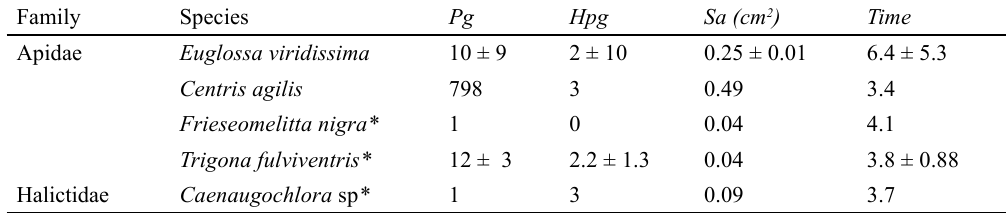
Table 2. Pollen loads on floral visitors and average time spent within the flowers of Martynia annua. Pg =